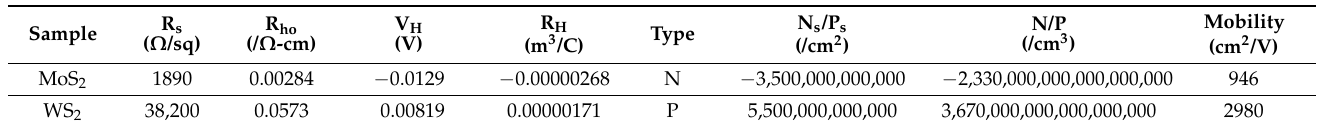
Table 2. Room-temperature surface resistance and Hall-effect measurements for MoS 2 and WS 2 on a silicon